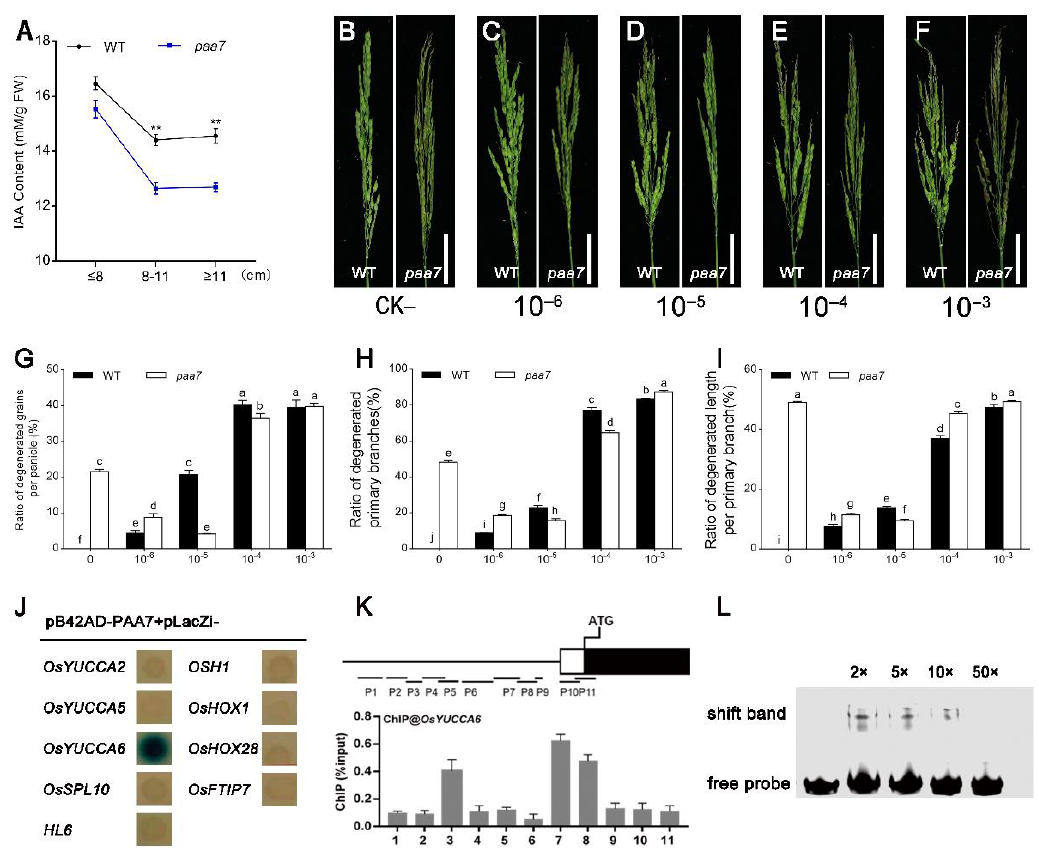
Figure 5. PAA7 regulates apical panicle degeneration through auxin pathway. ( A ) Auxin content in panicle of WT and paa7 at different developmental stages. Data are shown as means ± SD from three replicates (**, p < 0.01, Student’s t -test). ( B – F ) Phenotypes of WT and paa7 mutant plants treated with different concentrations of auxin. Bars = 5 cm. ( G – I ) Ratio of degenerated grains per panicle; ratio of degenerated primary branches; ratio of degenerated length per primary branch (data are shown as means ± SD from 10 replicates. Bars annotated with different letters represent values that are significantly different ( p < 0.05) according to a one-way ANOVA). ( J ) Y1H assay for interactions between FZP and auxin related genes. ( K ) ChIP-qPCR results show that PAA7 binds to the promoter of OsYUCCA6. ChIP enrichment compared with the input sample was tested using qPCR. Data are shown as means ± SD ( n = 3). ( L ) EMSA assays reveal that PAA7 directly binds to OsYUCCA6 promoter DNA fragments containing “CCGTTG”.